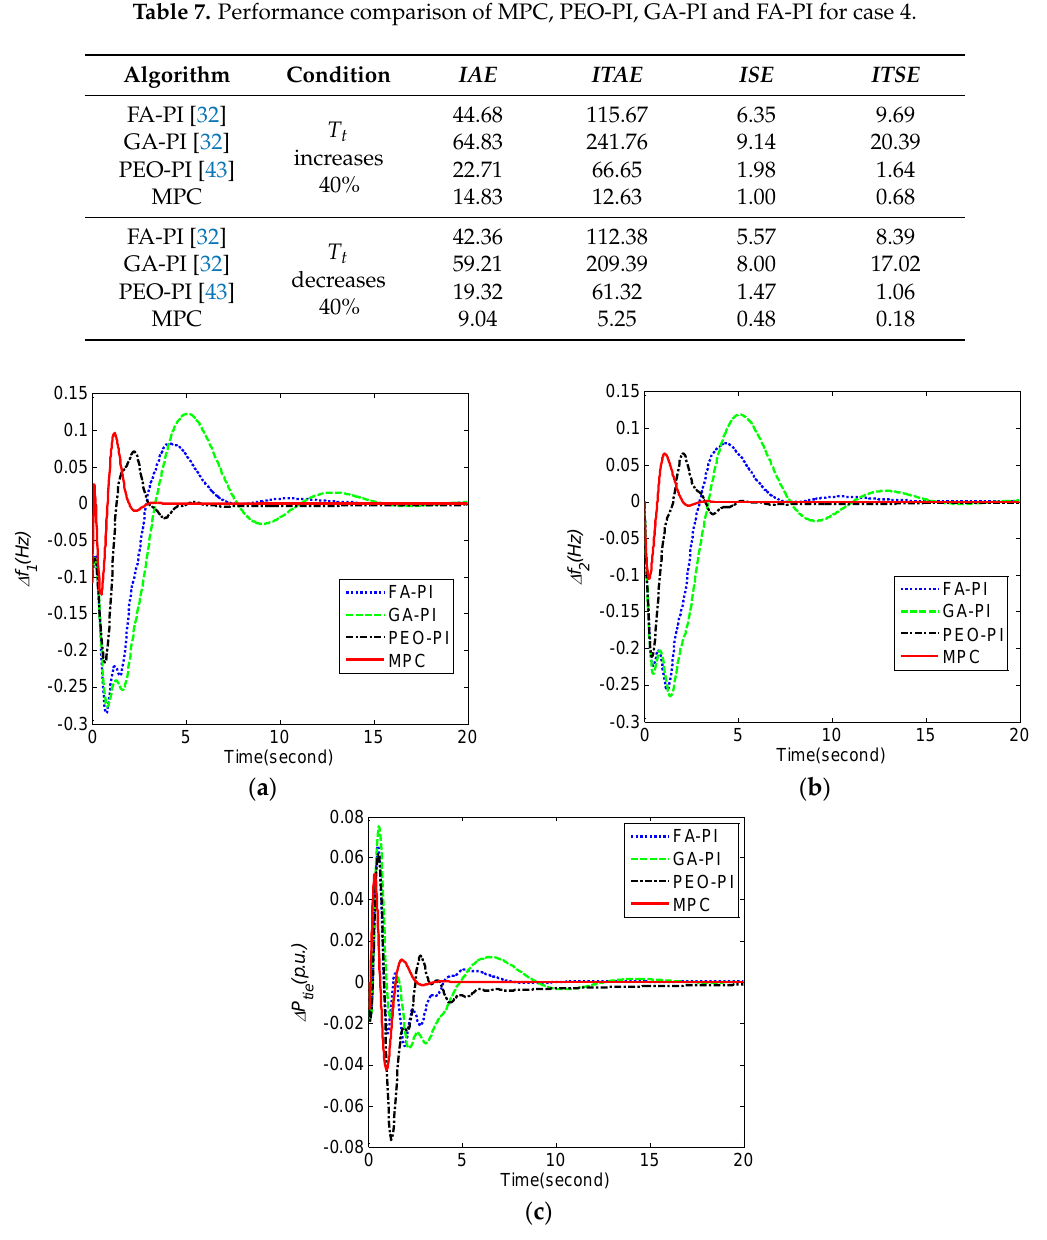
Figure 8. Comparison of frequency deviations ∆ f 1 , ∆ f 2 and tie line power deviation ∆ P tie obtained by different control methods under T t increasing 40% for case 4. ( a ) frequency deviation ∆ f 1 ; ( b ) frequency deviation ∆ f 2 ; ( c ) tie line power deviation ∆ P tie .